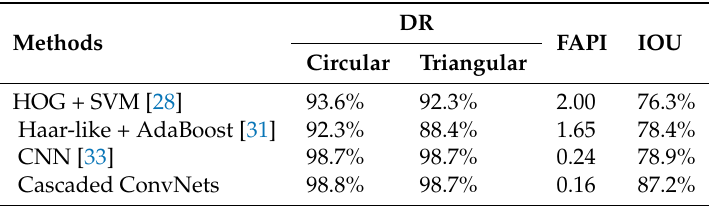
Table 2. Performance of different detection methods before the stage of supplemental training. DR, detection rate; FAPI, false alarms per image; IOU, intersection-over-union.